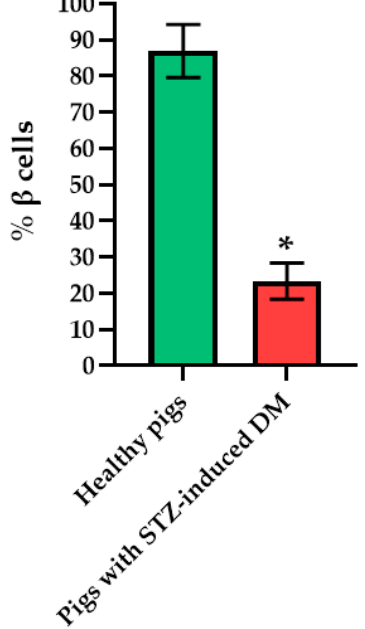
Figure 5. Histological (upper row) and immunohistochemical (lower row) analysis of the pig pancreas. ( a ) An islet of Langerhans of a healthy pig, and ( b ) an islet of Langerhans of a pig with STZ-induced DM. Staining with hematoxylin and eosin. Staining with antibodies to glucagon (red) and to insulin (green) and nuclei (blue).